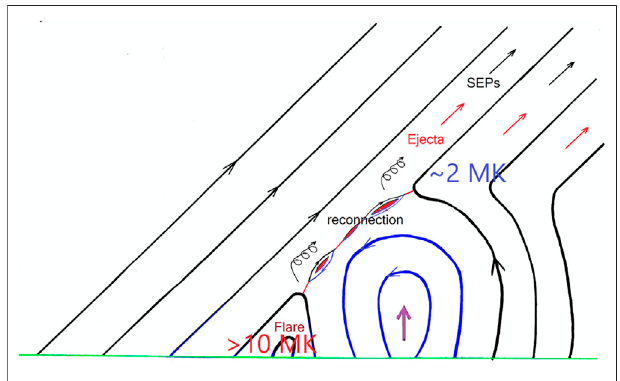
FIGURE 5 | A jet is produced when newly emerging magnetic fl ux ( blue ) reconnects with oppositely directed fi eld ( black ) in the red region. This reconnection region is not a uniform surface but forms multiple islands of reconnection. Energetic particles and plasma can escape toward the upper right and a newly-enclosed fl aring region labeled “ Flare ” forms at the lower left that is heated by trapping SEPs. Real jets can be much more complex, involving twisted fi elds,